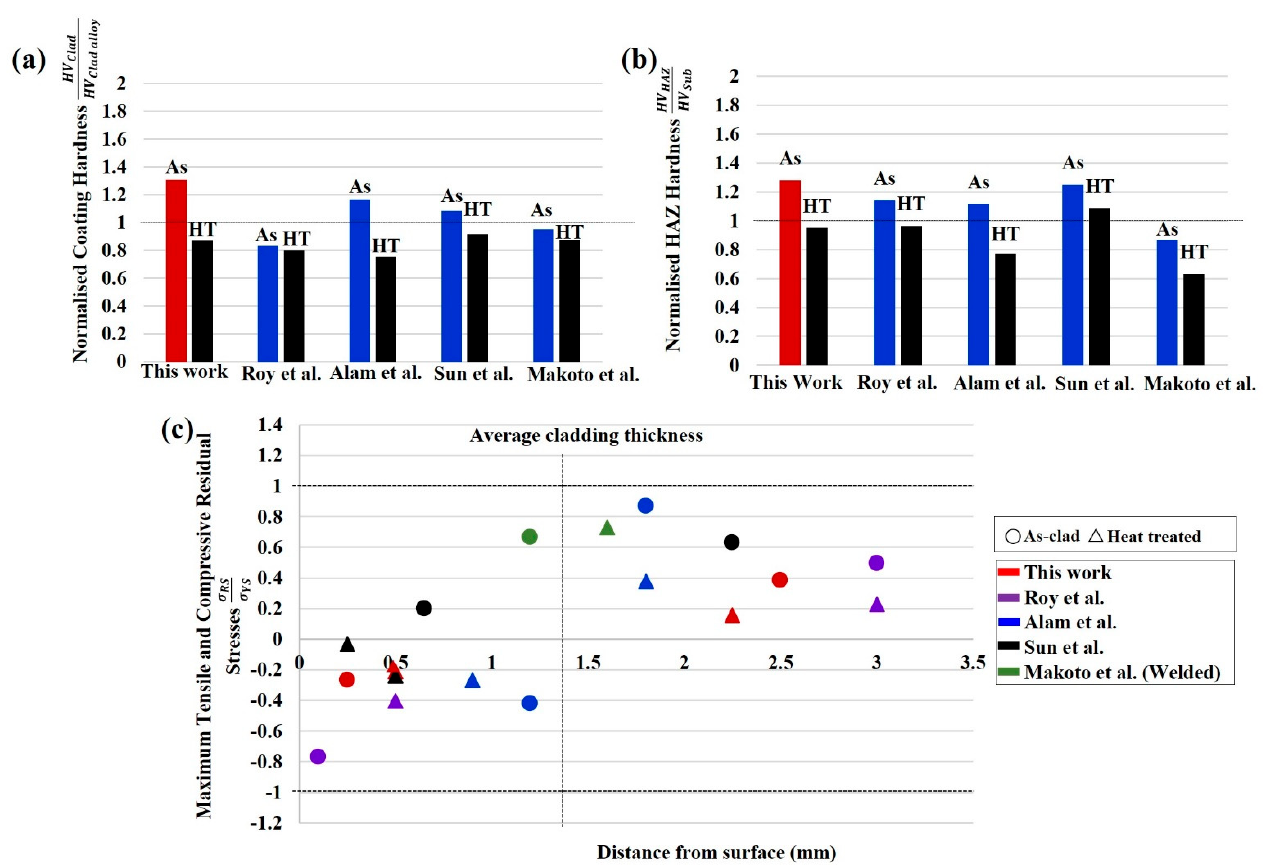
Figure 10. Comparison of 415SS with the current literature showing ( a ) cladding hardness normalised by the hardness of the cladding alloy, ( b ) HAZ hardness normalised by the hardness of the substrate material, ( c ) maximum tensile and compressive stress of laser clad and welded steel normalised by the yield stress of the cladding alloy and substrate material.